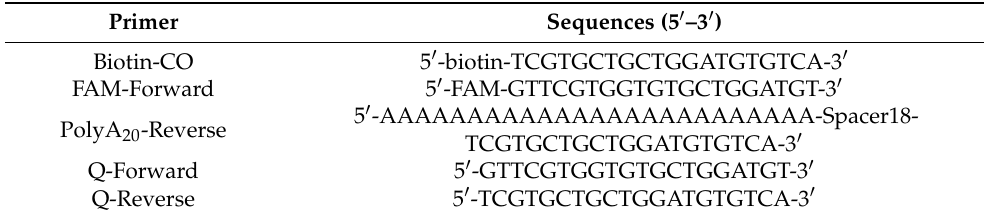
Table 1. Primer sequences used in SELEX.